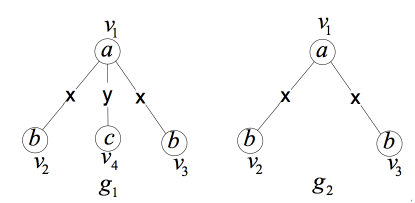
Figure 1. An example of an induced subgraph.